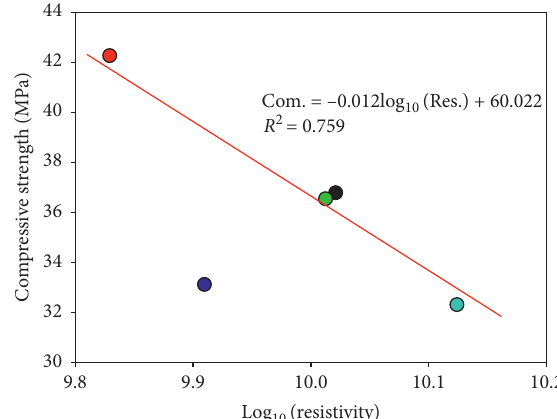
Figure 7: Relationship between compressive strength and resis- tivity of GTC (0% to 40%).